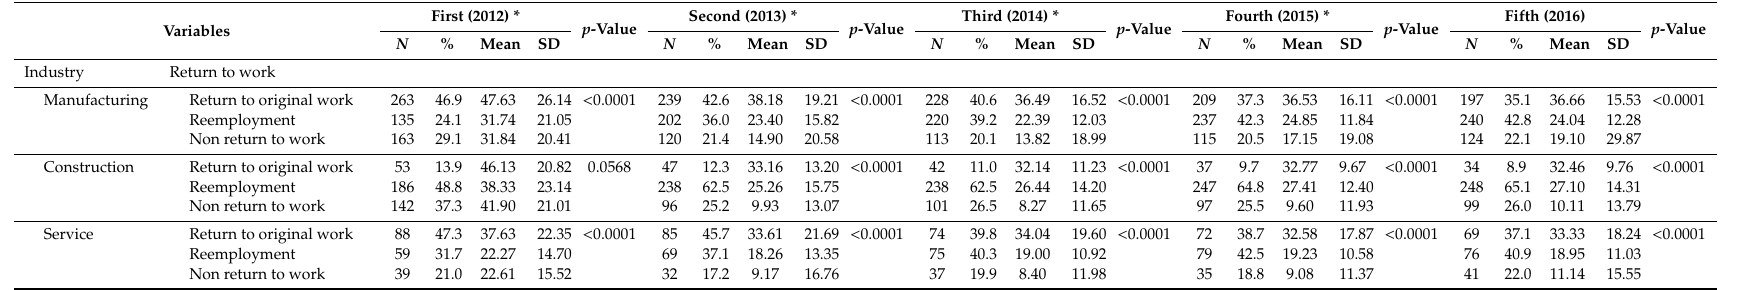
Table 4. Annual income characteristics between the industry and return to work (unit: million